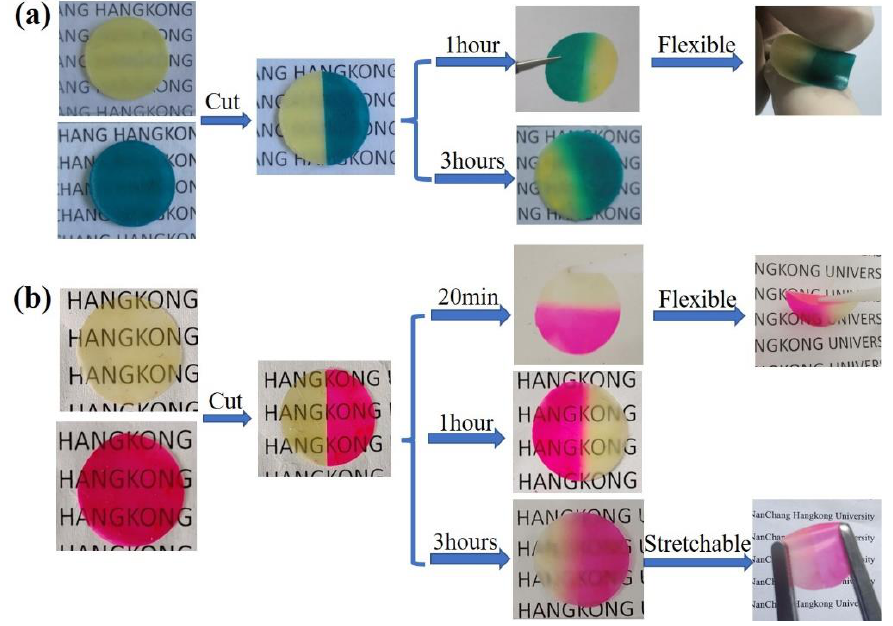
Figure 3. Self−healing process of ( a ) polymer MCIG PE−0 and ( b ) gel polymer electrolyte MCIG- Figure 3. Self − healing process of ( a ) polymer MCIGPE − 0 and ( b ) gel polymer electrolyte PE−65 at room temperature. MCIGPE − 65 at room temperature.